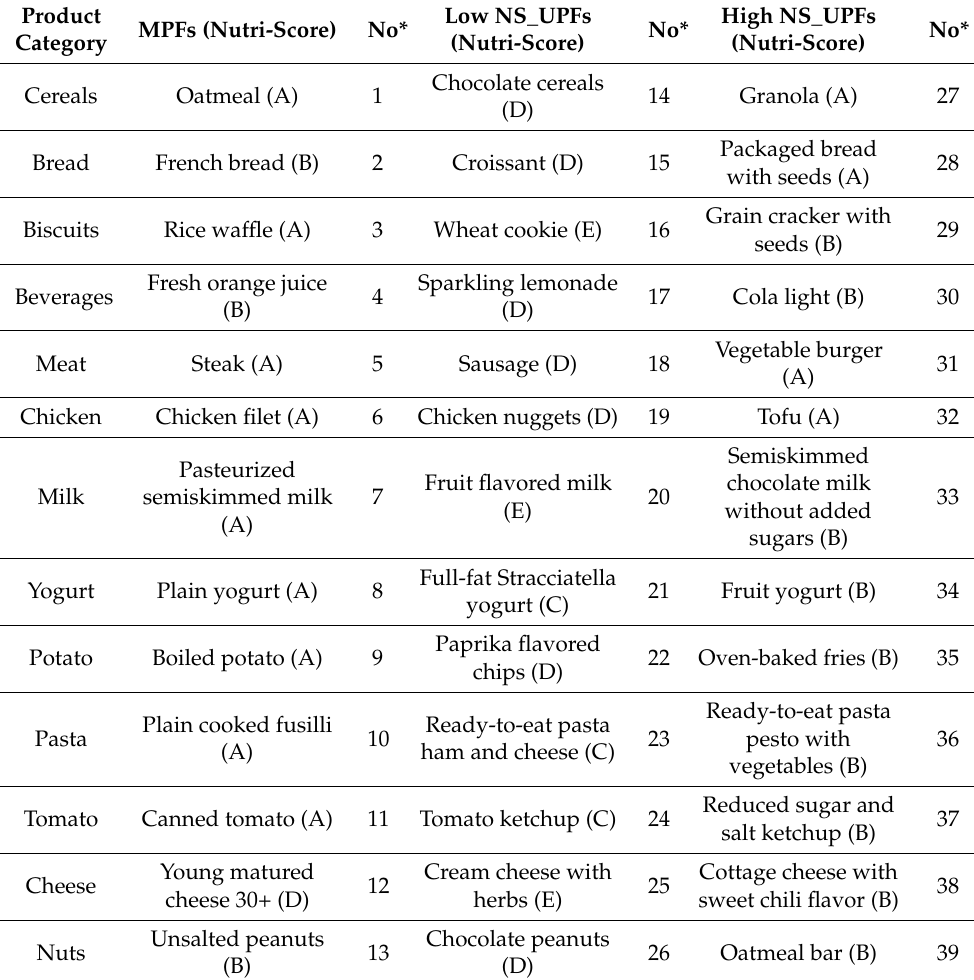
Table 1. All food categories and products grouped by degree of processing (NOVA) and healthiness